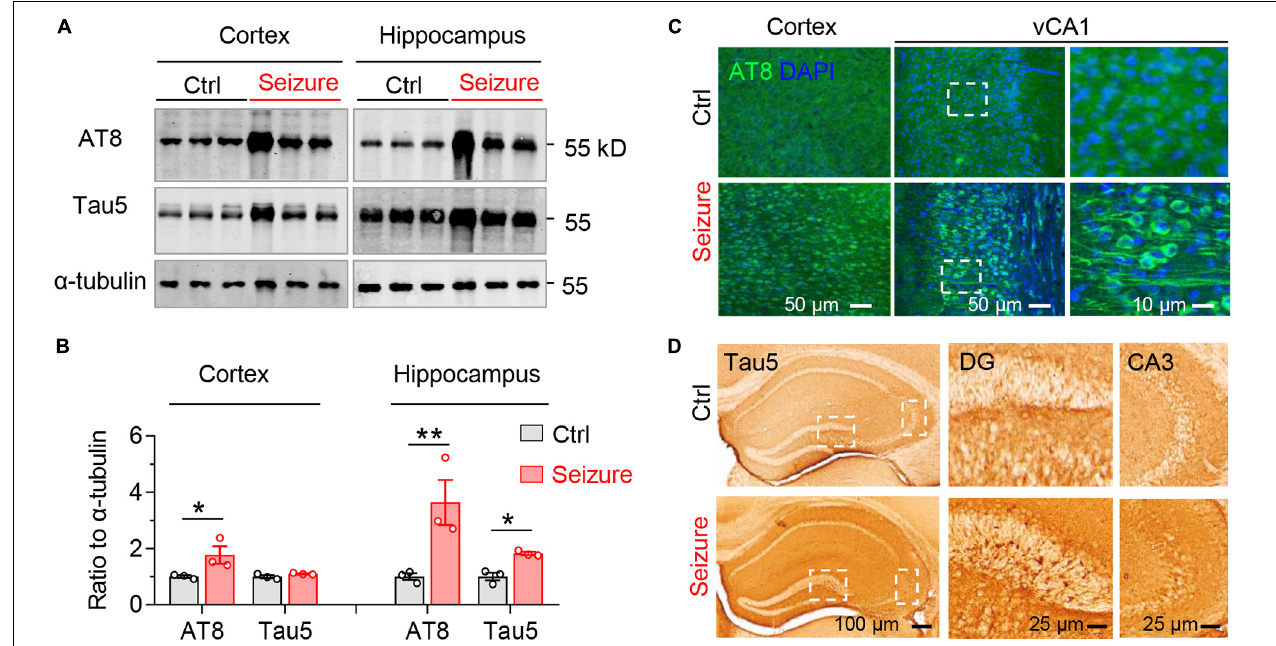
FIGURE 3 | Repeated seizures upregulate phosphorylated and total tau levels in the hippocampus and cortex of mice. Repeated seizures increased phospho-tau (AT8) and total tau (Tau5) levels in hippocampus and cortex measured by Western blotting (A,B) and immunostaining (C,D) . n = 3 mice in each group. Unpaired t -tests, * p < 0.05, ** p < 0.01. Scale bars were as indicated in each panel. Values are presented as the mean ±